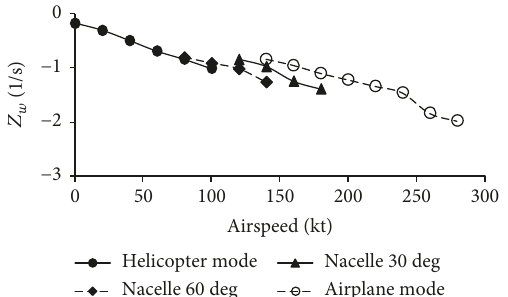
Figure 9: Variation of the derivative Z